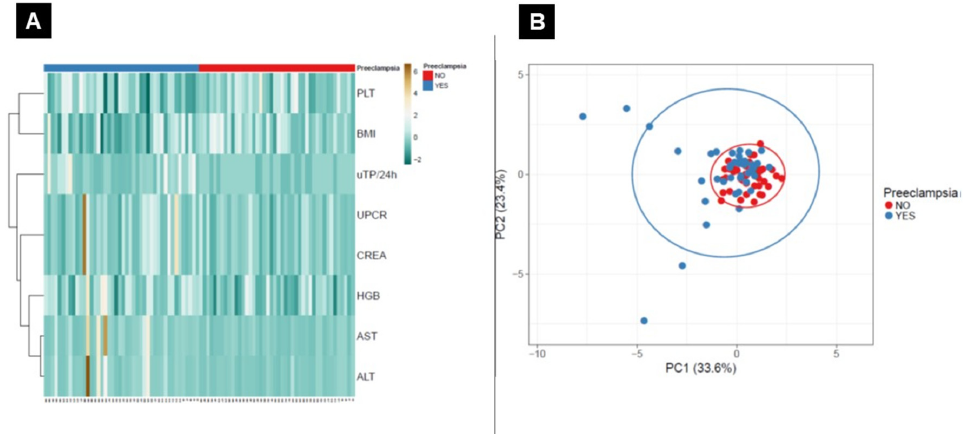
Figure 4 . Heat maps and principal component analysis (PCA) analysis. Heat maps based on the Euclidean distance between clusters for patients with PE and GH ( A ). PCA graph for the PE and GH groups ( B ). The X and Y axes show principal component 1 and principal component 2, which explain 33.6% and 23.4% of the total variance, respectively.